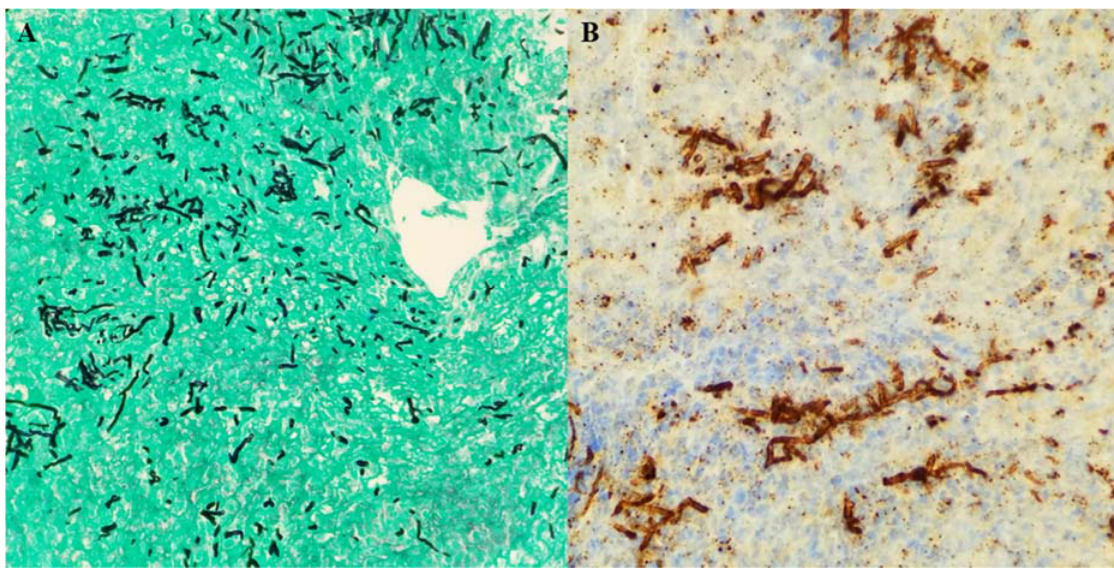
Figure 2. ( A ) Histopathology showing fungal elements in hyphal form with acute branching and vague septae (Gomori Methenamine Silver stain, 100×) ( B ) Positive immunohistochemistry for Aspergillus (Immunostaining, 200×).